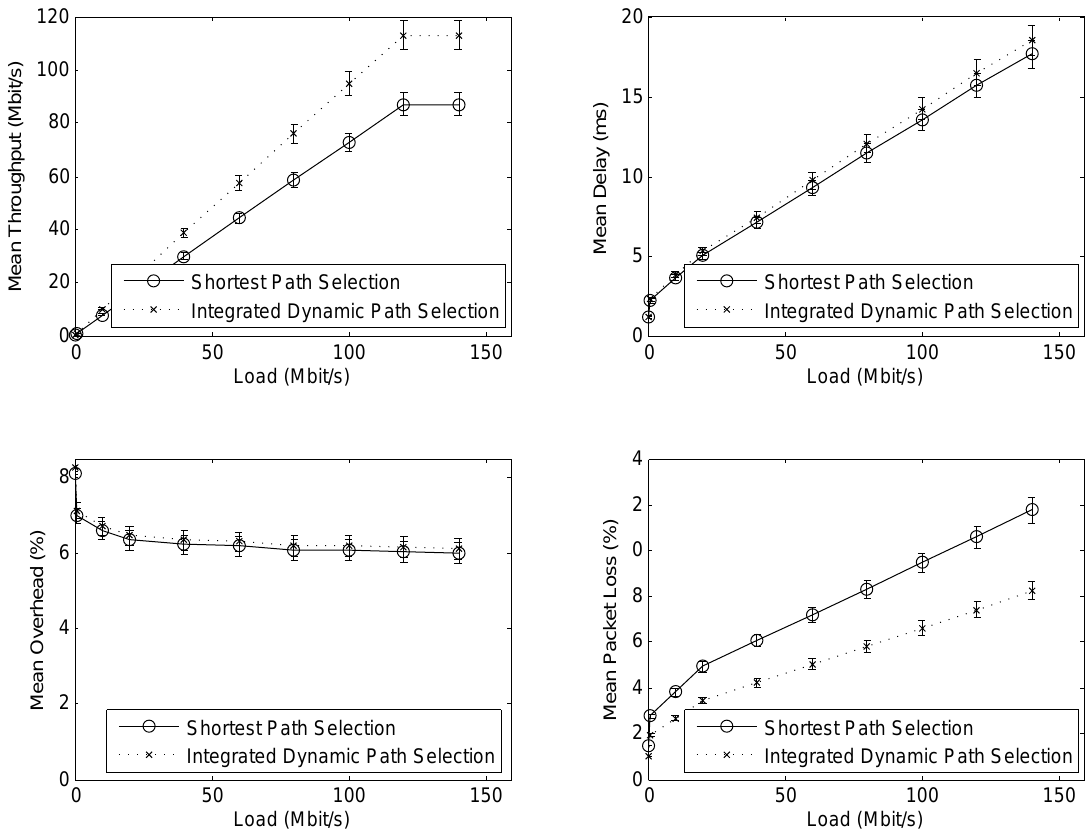
Figure 14. Impact of path selection schemes on FiWi network performance using advanced aggregation techniques and wireless mesh